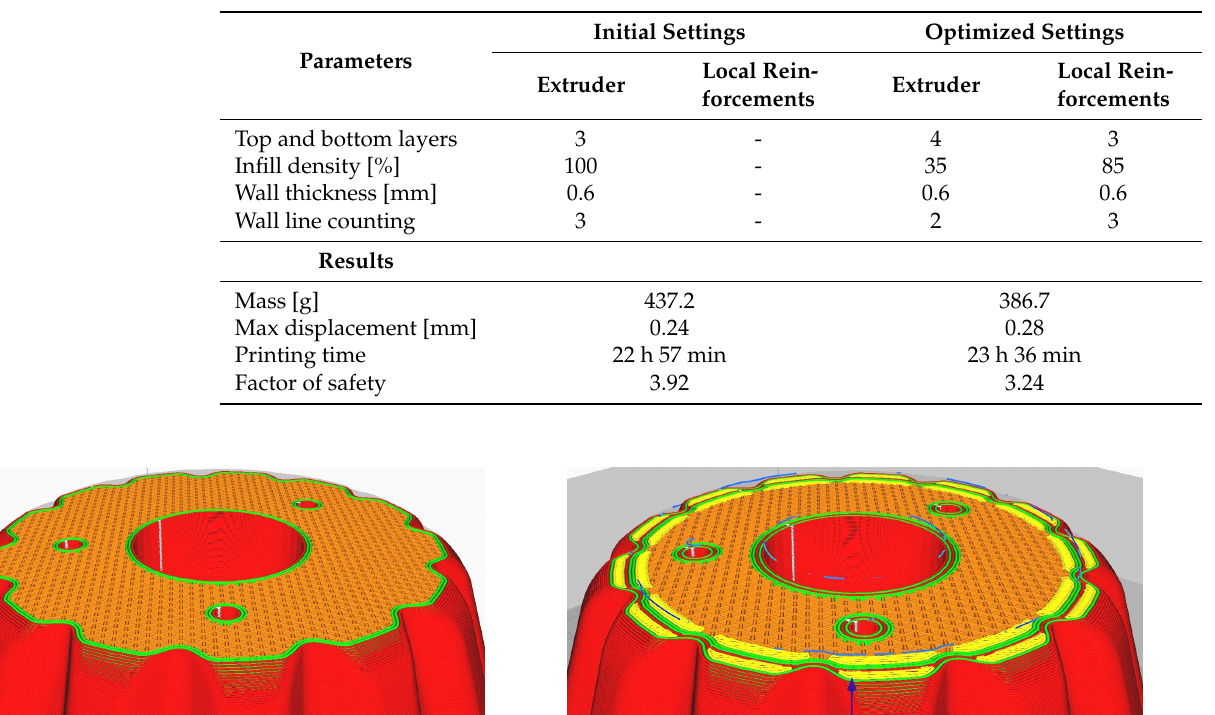
Table 3. 3D printing optimization parameters and comparison of results.